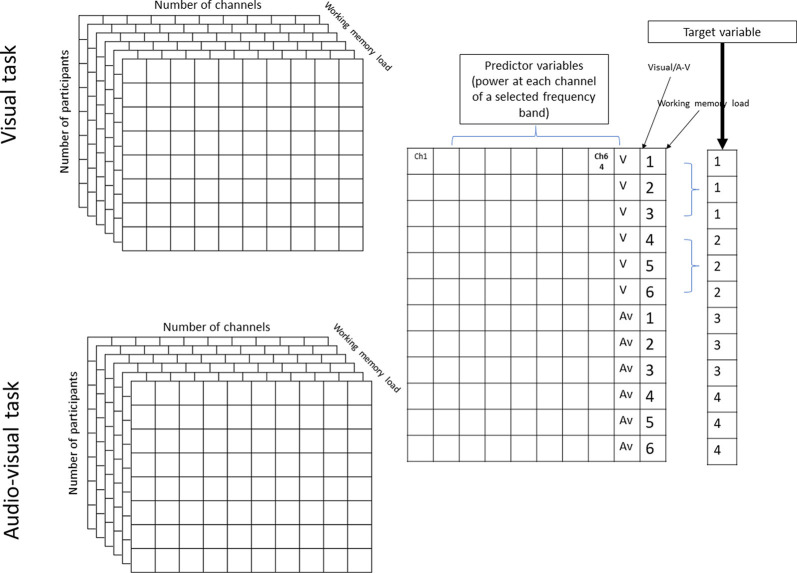
Graphical representation of realignment of population results of one frequency band.